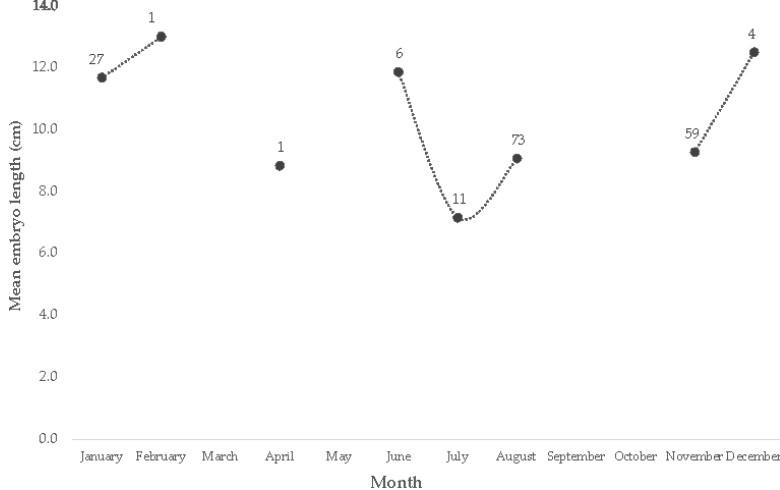
Figure 4. Average monthly size of embryos of U. chilensis observed in the SGC. The numbers represent the observations per month. GSI and HSI